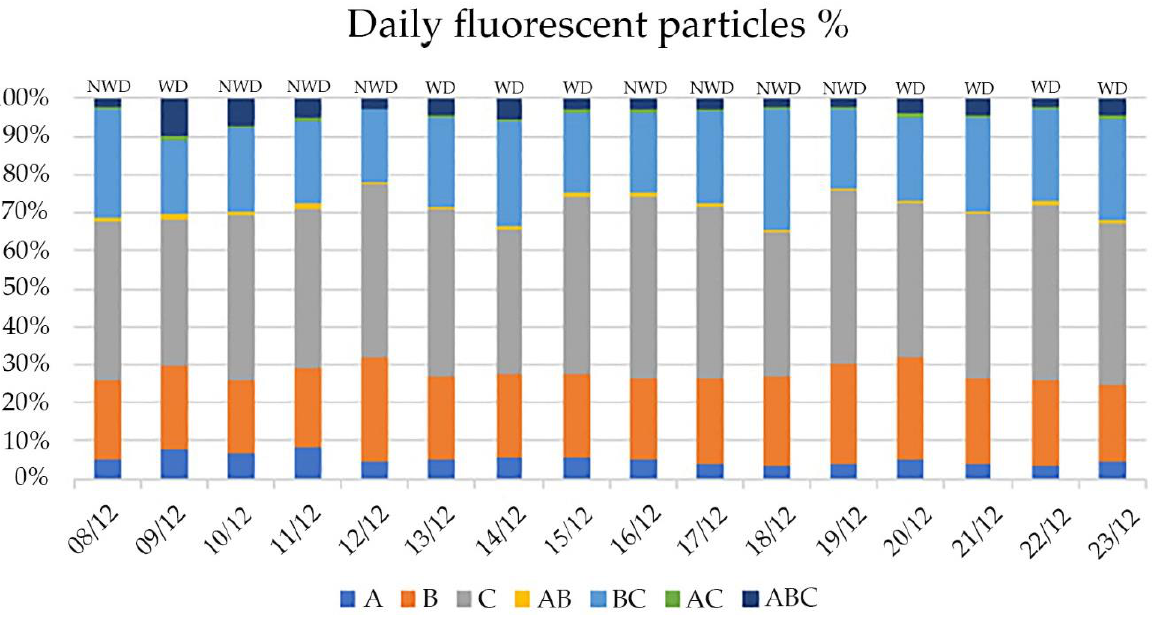
Figure 4. Percentage distribution of fluorescent particles in different channels (y-axis) for each day of sampling (x-axis).